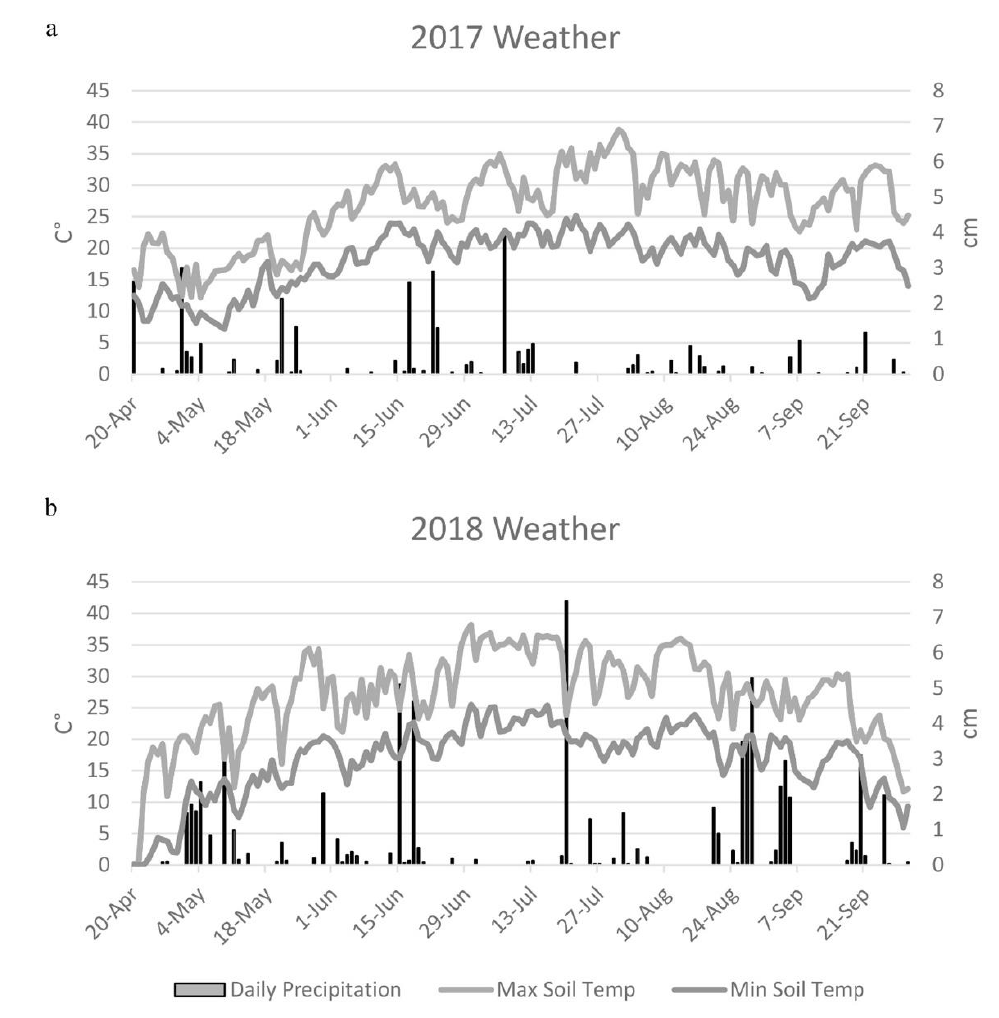
Figure 2. Daily maximum and minimum soil temperatures and precipitation between planting and harvesting in 2017 ( a ) and 2018 ( b ).